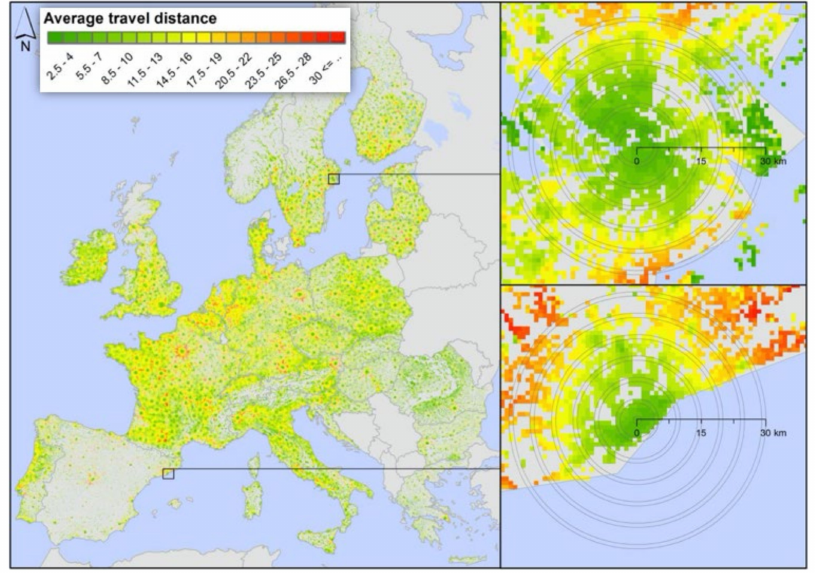
Figure 4. Average travel distances (km) in Europe, with focus on Stockholm and Barcelona, showing the dependence of the average distance on the distance from the metropolitan area [49].